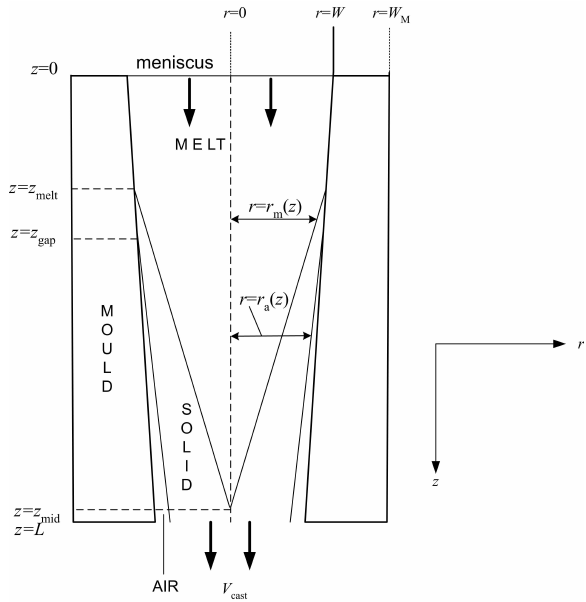
Figure 7. A 2D schematic of the continuous casting process with tapered mould walls and